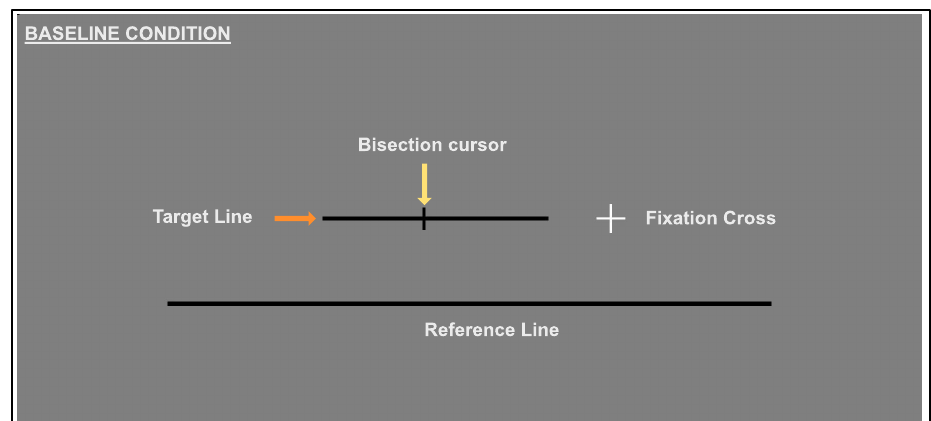
Figure 1. Baseline Condition: Target lines (of varying lengths) appeared at a randomised distance from the fixation cross, which was to the left of centre for the right-blind, and right of centre for left-blind conditions. A reference line was presented below the target.